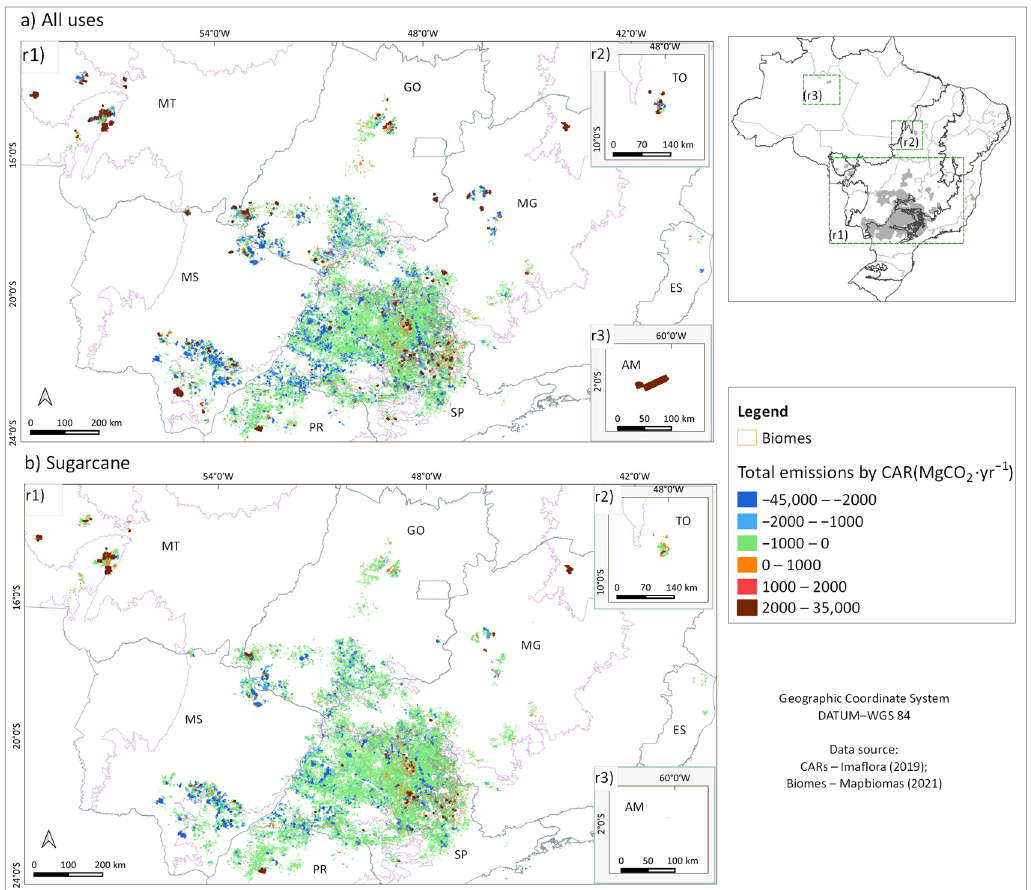
Figure 11. Total annual net emissions/removals (MgCO 2 ∙ yr − 1 ) in parametrization D for each CAR in 2000–2020 due to ( a ) all LUC that occurred only within CARs and ( b ) the LUC that occurred only in sugarcane areas in 2020 within CARs.